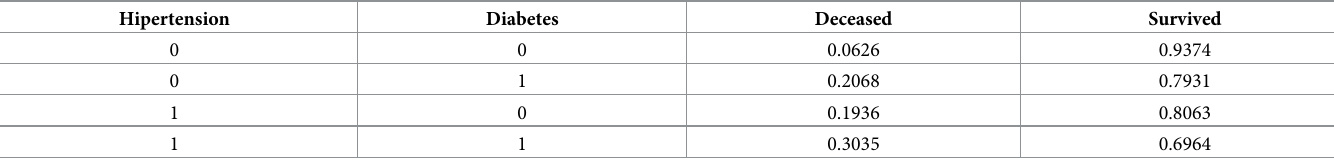
Table 4. Contingency table of the survival of a hospitalized patient.